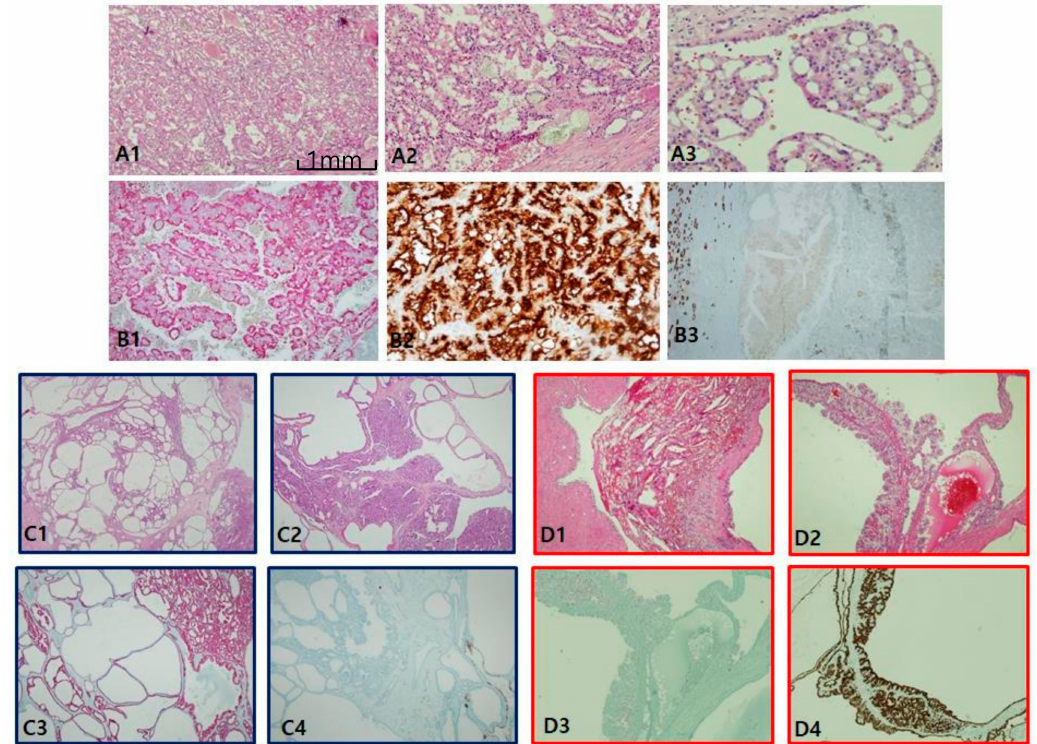
Figure 4. Acquired cystic disease-associated renal cell carcinoma (ACD-RCC). ( A1 – A3 ) In ACD-RCC, characteristic feature includes lace pattern ( A1 ) with intratumoral oxalate crystals ( A2 ) and coalescent vacuoles ( A3 ). ( B1 – B3 ) Immunoprofiles of ACD-RCC. Similar to papillary renal cell